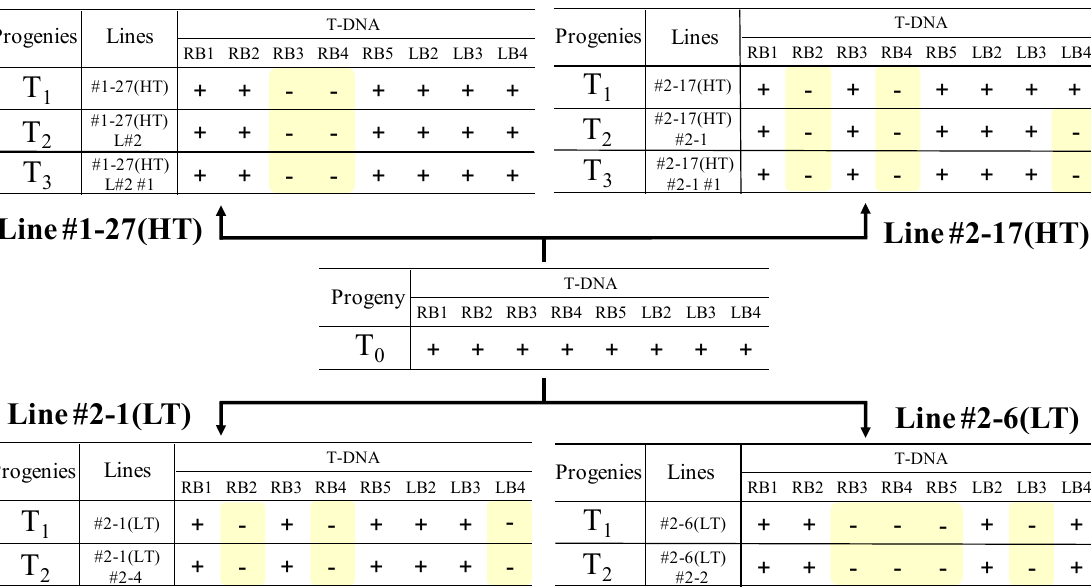
Figure 6. Inheritance of the eight independent T-DNA insertion loci (RB1, RB2, RB3, RB4, RB5, LB2, LB3, and LB4) in the representative four lines of selfed progenies. (+: Insertion locus detected; -: insertion locus not